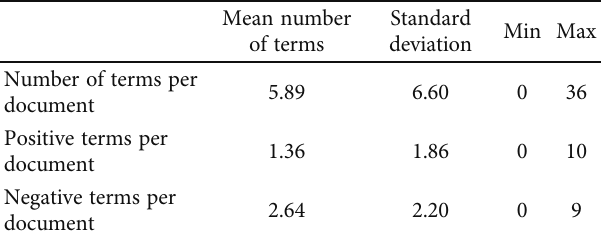
Table 5: Number of emotion terms used in the